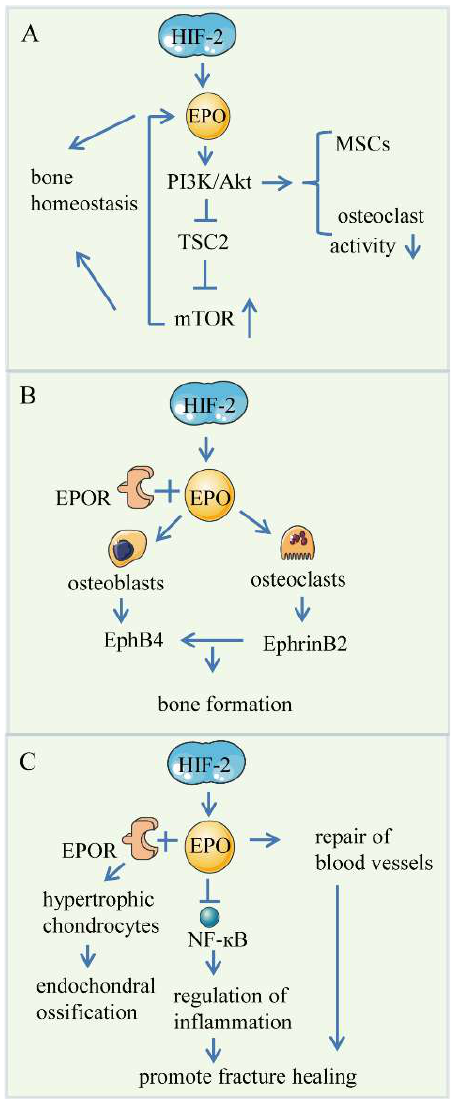
Figure 4. HIFs/EPO pathway. ( A ) PI3K/Akt signaling pathway. EPO stimulation activates PI3-kinase, and protein kinase B (PKB)/protein kinase-B (Akt) is activated downstream of PI3-kinase. Activated Akt phosphorylates decrease the ability of TSC2 to inhibit mTOR, resulting in the activation of mTOR, which mediates bone. EPO directly promotes the differentiation of MSCs into osteoblasts via the PI3K/AKT signal pathway and decreases osteoclast activity at the same time. ( B ) EphrinB2/EphB4 signaling pathway. EPO induces enhanced expression of EphB4 by osteoblasts, which, when activated by EphrinB2 expressed by osteoclasts, leads to enhanced osteoblast activity, increasing bone formation. ( C ) Skeletal repair. EPO lowers NF- κ B expression and regulates inflamma- tion, promoting fracture healing. At the same time, EPCs migrate to ischaemic areas or defect sites to improve the repair of blood vessels. EPO interacts with EPOR-expressed hypertrophic chondrocytes to promote endochondral